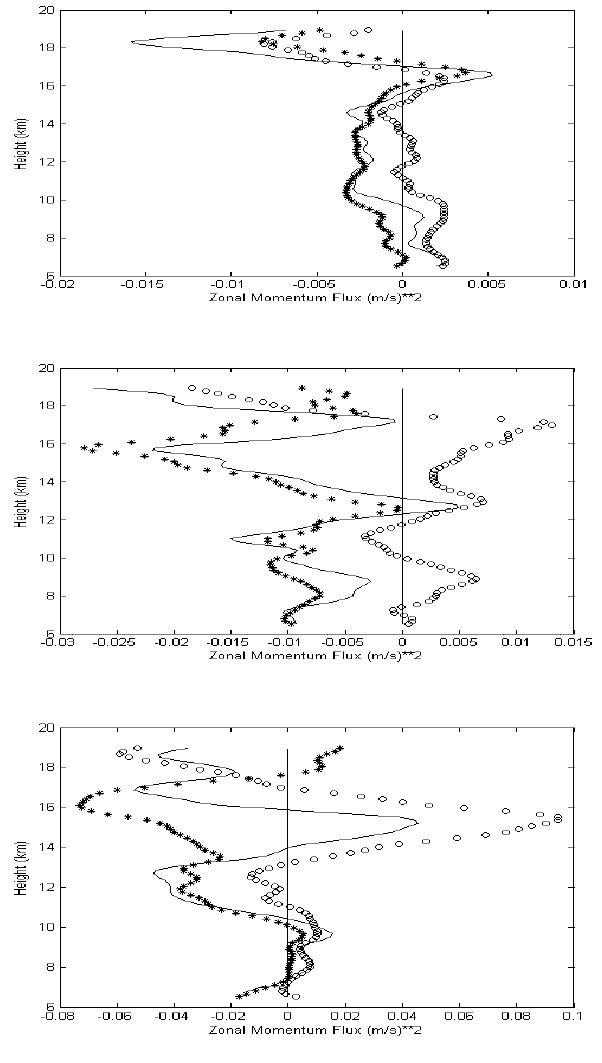
Fig. 7. Expanded version of the 1st 24h (quiet period) averaged Fig7 Expanded version of the 1st 24 hours (quiet period) averaged profiles of upward flux profiles of upward flux (open circle), downward flux (star),and (open circle), downward flux (star),and total flux (line) of zonal momentum for 10- 30 total flux (line) of zonal momentum for 10–30min periods (top min periods (top panel); 30 min- 2 h periods (middle panel), and 2- 7 h periods (bottom panel); 30min–2h periods (middle panel), and 2–7h periods (bot- tom panel). panel).